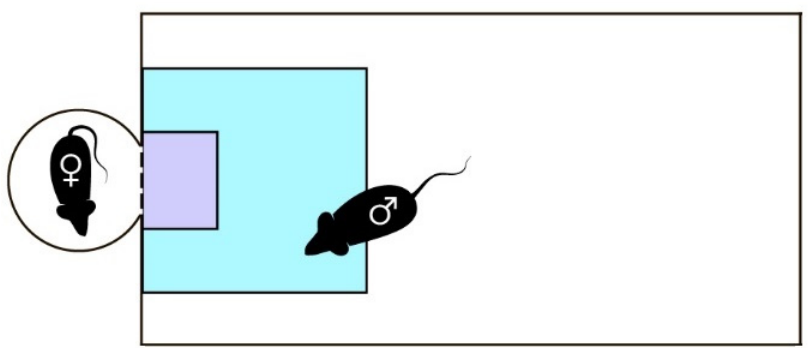
Figure 1. Modified sexual incentive motivation test setup. Setup includes experimental chamber (15 × 30 × 50 cm 3 ) and incentive cage separated by a wire-screen (dashed line) from each chamber. White circle with female mouse—incentive cage; blue square—“female” zone, 10 × 10 cm 2 ; purple rectangle—“nose” zone, 4 × 3 cm 2 .